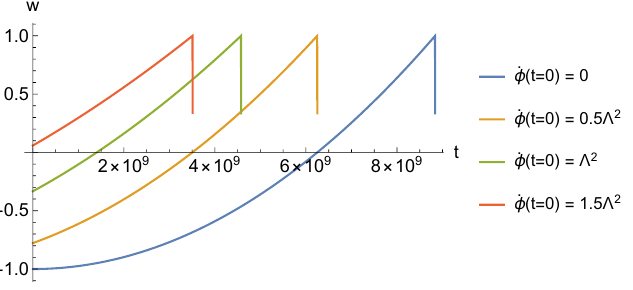
Figure 38 . Equation of state of the universe in model with self-stopping relaxion, for (cid:3) b = 800 GeV, (cid:3) = 8 TeV, g = 2 10 (cid:0) 14 , and f is determined by the stopping condition. This corresponds (cid:2) to the cases in (cid:12)gure 37 where the relaxion dominates the energy